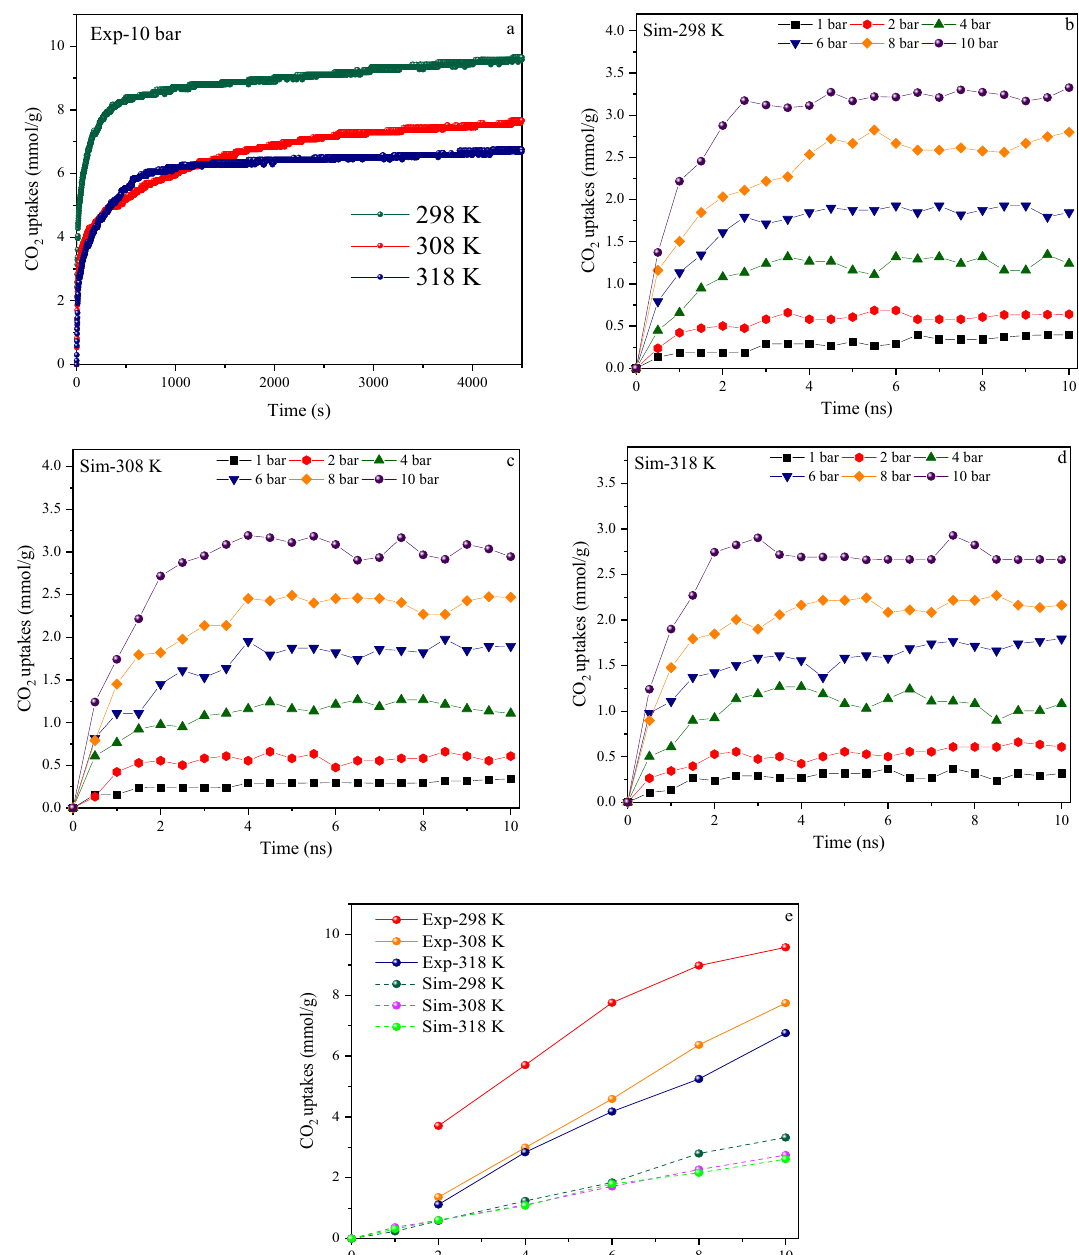
Figure 4. (a) Experimental CO 2 Adsorption isotherms under 10 bar pressure at 298–318 K for 4500 Sec. ( a ); ( b ), ( c ), and ( d ) Simulation CO 2 adsorption capacity at 298 K, 308 K, and 318 K, in the range of 1–10 bar pressure for 10 ns; ( e ) Comparison of experimental and simulation CO 2 adsorption isotherm in the range of 1–10